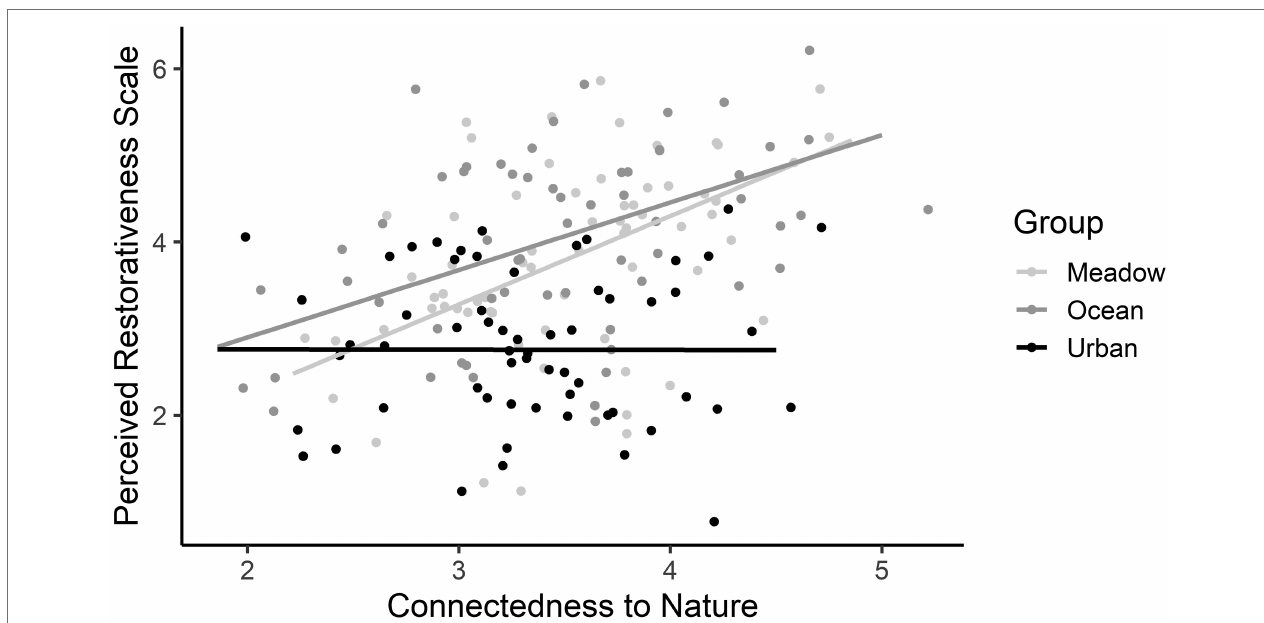
FIGURE 5 | The interaction between Connectedness to Nature Scale scores and group on the Perceived Restorativeness Scale scores, from Study 2. The grey shading represents the 95% confidence